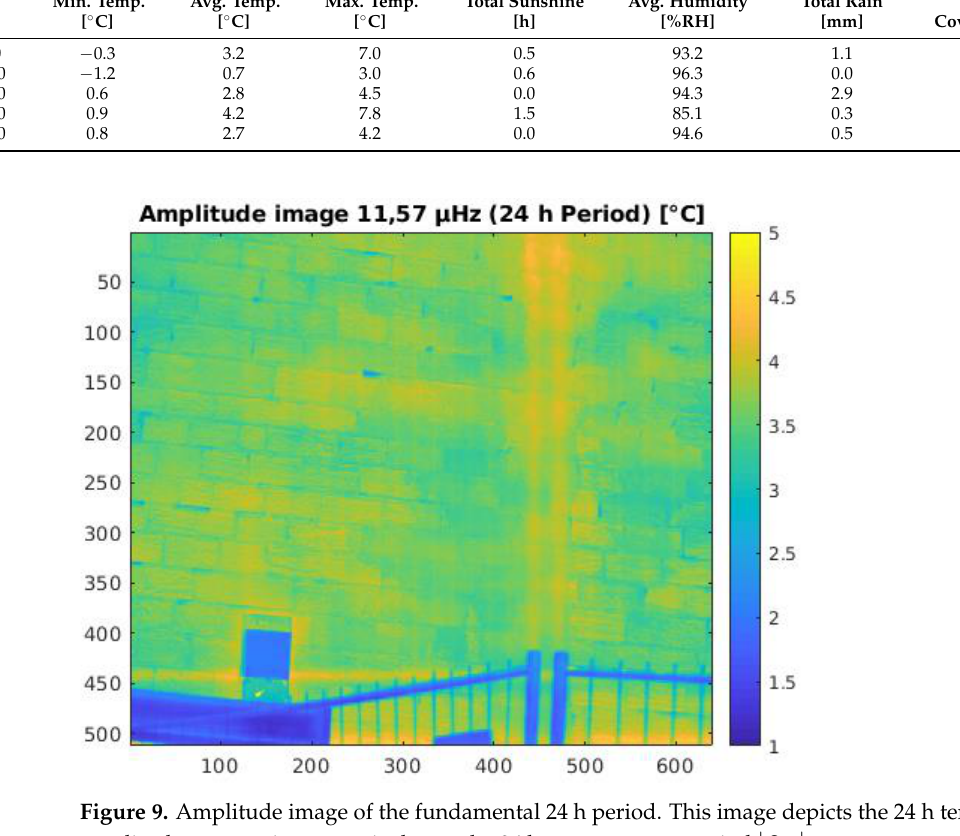
(cid:12) (cid:12) (cid:12) S xy (cid:12) .